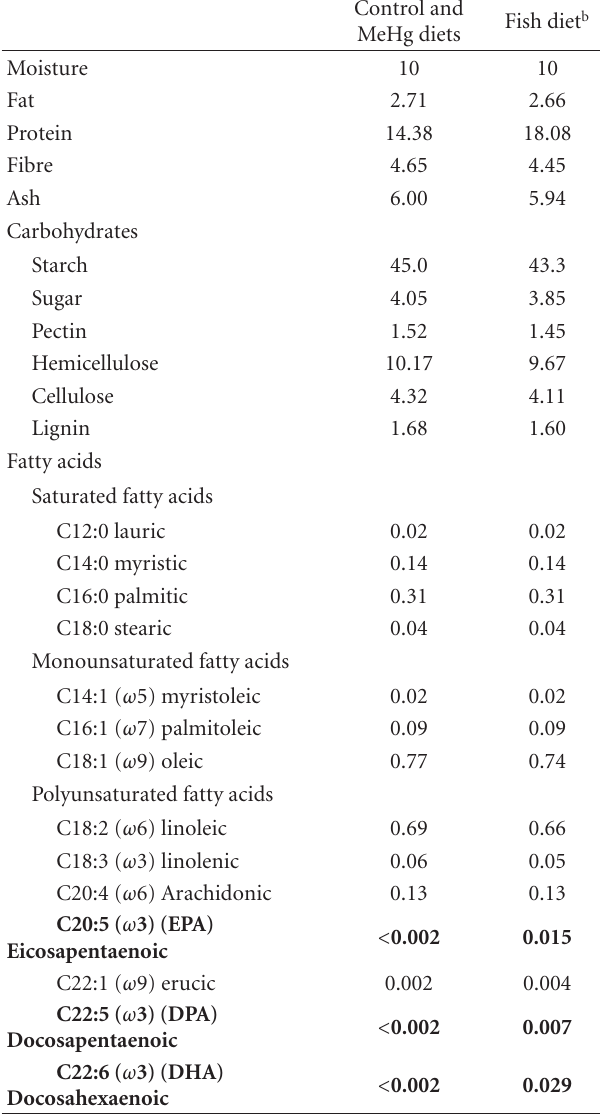
Table 1: The composition of the diets used a . Control